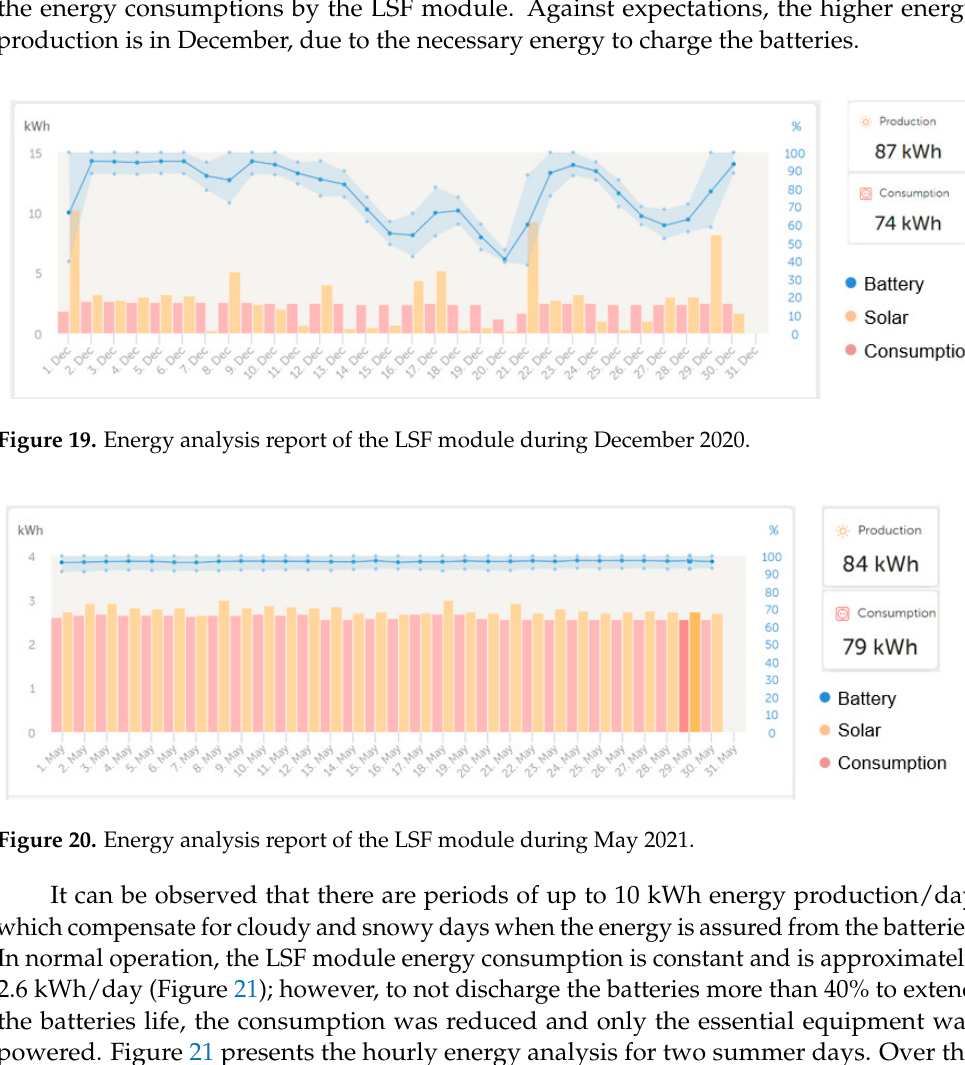
Figure 18. Carbon dioxide (CO 2 ) concentration within the experimental module.